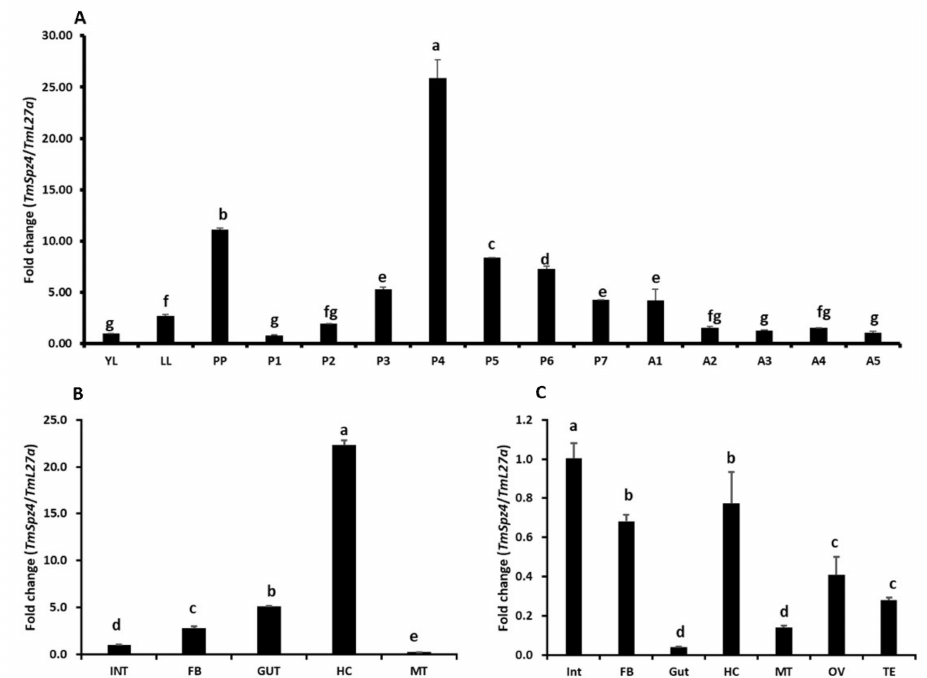
Figure 2. The expression patterns of TmSpz4 gene in developmental and tissue of T. molitor. The developmental expression patterns of TmSpz4 in mealworm at the young larval (YL), late larval (LL), pre-pupal (PP), 1–7-day-old pupal (P1–7), and 1–5-day-old adult (A1–5) stages were examined ( A ). In each experiment, RNA extracted from 20 individuals was used to synthesize cDNA. In larvae, TmSpz4 expression gradually increased from the YL to the PP stage. In the pupae, the highest expression was observed at the 4-day-old pupal stage. In adults, there was no difference in TmSpz4 expression from day 2 to day 5. Tissue-specific expression patterns of TmSpz4 were also investigated in late larvae ( B ) and five-day-old adults ( C ). Hemocytes (HC), gut, fat body (FB), Malpighian tubules (MT), integument (INT) (for late instar larvae and adults), and testes (TE) and ovaries (OV) (for adults) were dissected and collected from 20 late larvae and 5-day-old adults. T. molitor 60S ribosomal protein L27a ( TmL27a ) was included as an endogenous control to normalize RNA levels among samples. The data are the means of three biological replicates. One-way ANOVA and Tukey’s multiple range test at 95% confidence level ( p < 0.05) were performed and used to determine the level of significance of differences. The graph indicated by the same letter (a, b, c, d, e, f, g, fg) are not significantly different by Tukey’s multiple range ( p <